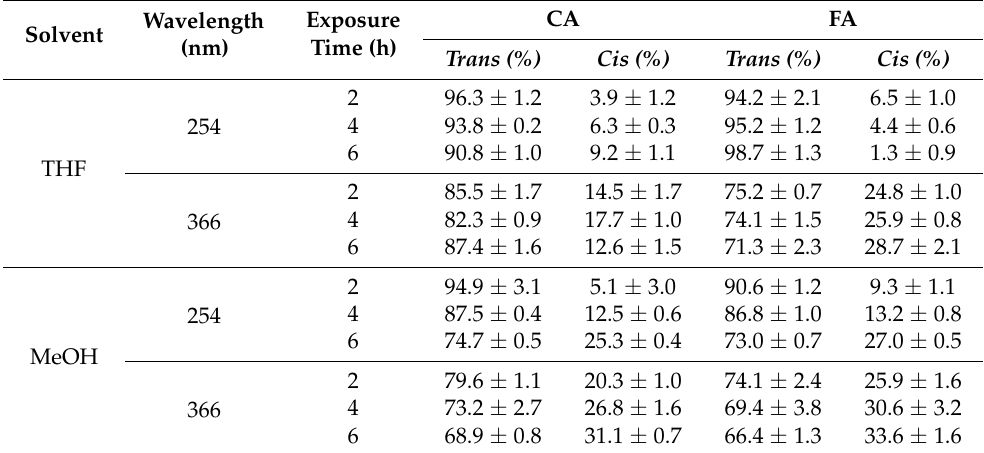
Table 3. Isomerization of trans -CA and trans -FA dissolved in THF or MeOH under the influence of UV radiation at two wavelengths (254 nm and 366